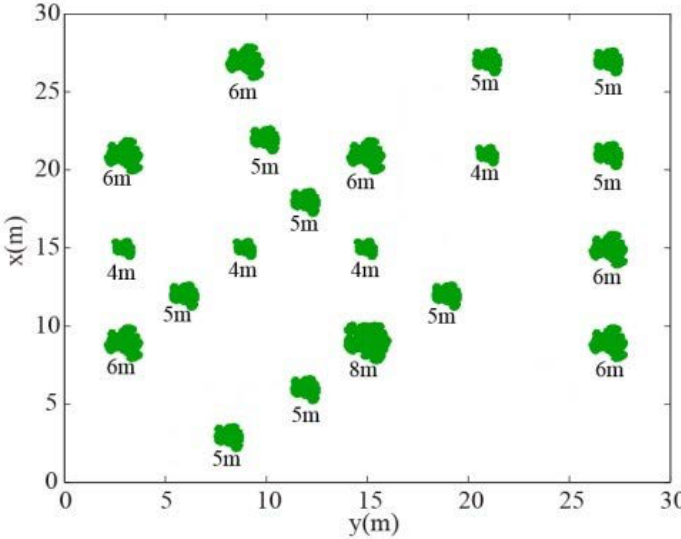
Figure 5. The distribution and height of each tree in a stand.